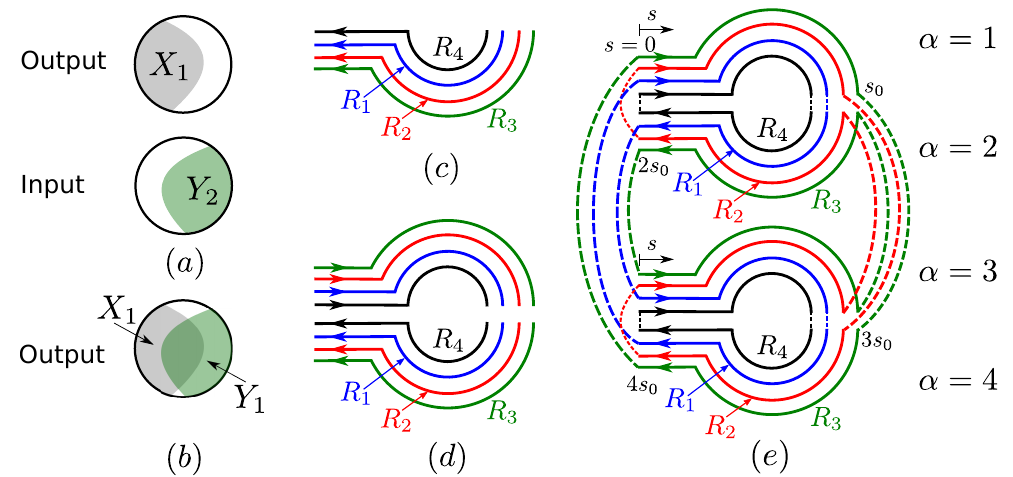
Figure 3: (a) Setup of the TFD state for the SYK model. The two circles represent the the output and input Hilbert spaces and the corresponding spatial bipartitions into / X / Y X and Y , respectively. (b) The output Hilbert space, with Y , the region 1 1 1 1 1 corresponding to Y in the input Hilbert space, depicted alongside X . (c) A contour 2 1 representation of the TFD state. Starting from the maximally entangled state | I 〉 , 12 the output Hilbert space is evolved for an imaginary time ε/ 2 (represented by the curved lines) and then by a real time t (represented by horizontal lines). The arrows indicate the direction of real time evolution. We depict the evolution for the fermions in each of the spatial subregions R , defined in Eq. (99). (d) Contour representation i of the full TFD density matrix. (e) Contour representation of the Rényi entropy of Eq. (98). The dashed lines indicate the traces for each of the R regions. Also indicated i = t + ε/ 2. is our parameterization of the contour in terms of s , where we have set s 0 Lastly, the number α labels the four contour segments (see Appendix